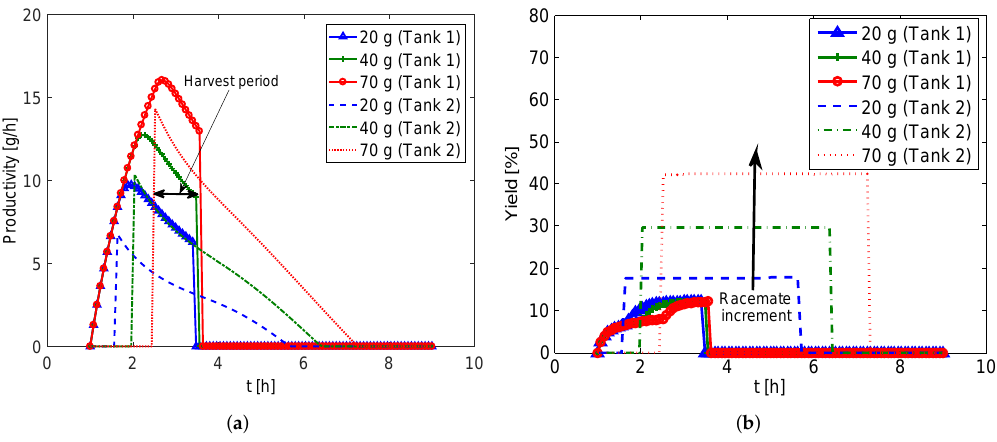
Figure 9. Simulation results showing effect of racemate mass on the productivity and yield of coupled preferential crystallization-dissolution (CPC-D) configuration (seed mass 2 g, exchange rate 80 mL min − 1 ). ( a ) Productivity for Tank 1 and Tank 2; ( b ) Yield for Tank 1 and Tank